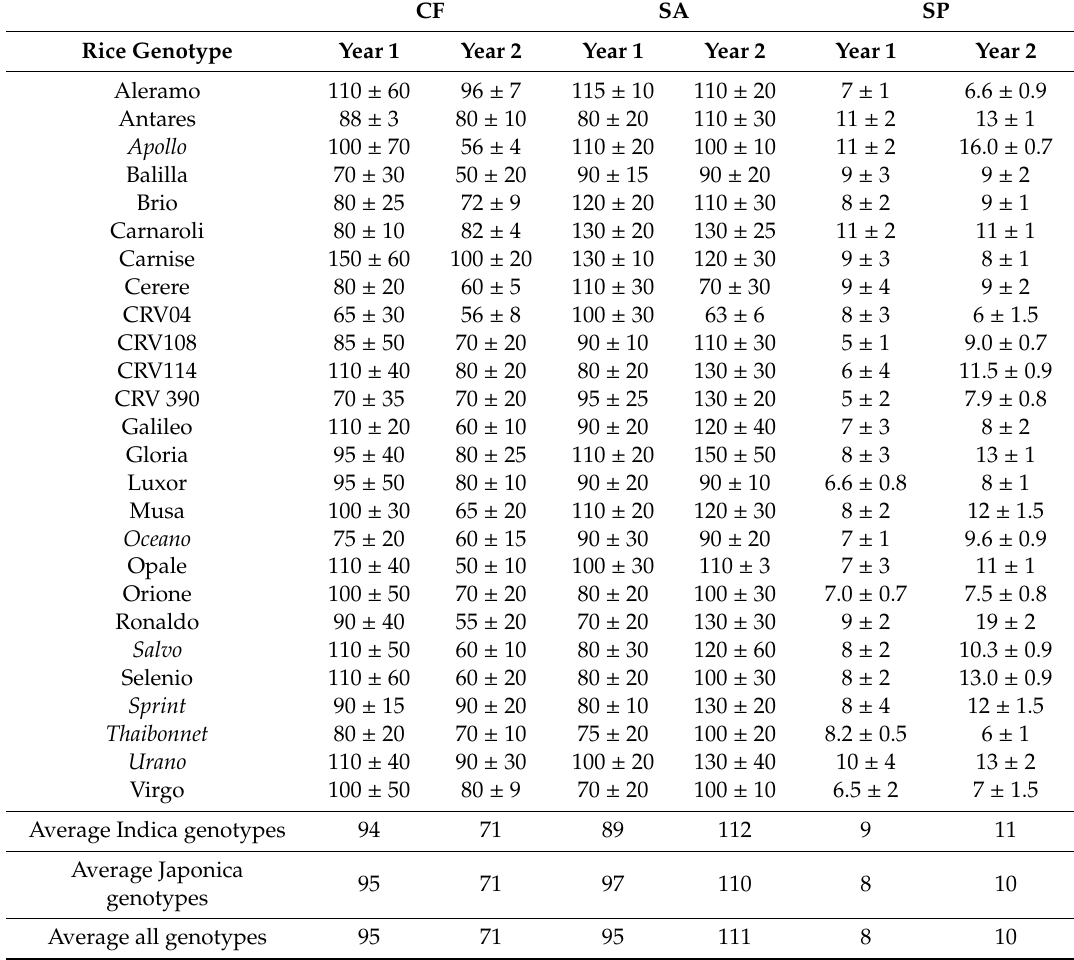
Table 2. Total Se amounts ( µ g kg − 1 ± s) in grains of 26 rice genotypes cultivated along two consecutive crop years with three di ff erent irrigation methods: continuous flooding (CF), saturation (SA), and sprinkler (SP)